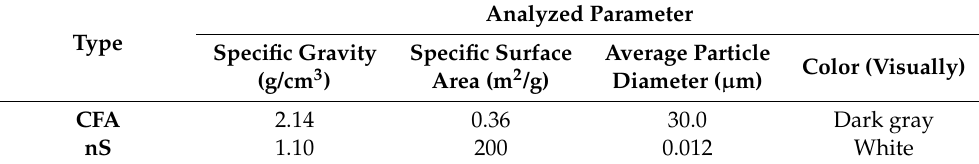
Table 3. Physical properties of mineral additions.